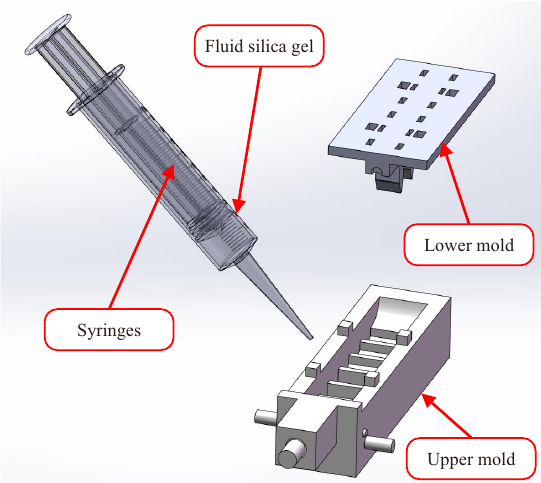
Figure 2. Injection molding process of the upper mold.